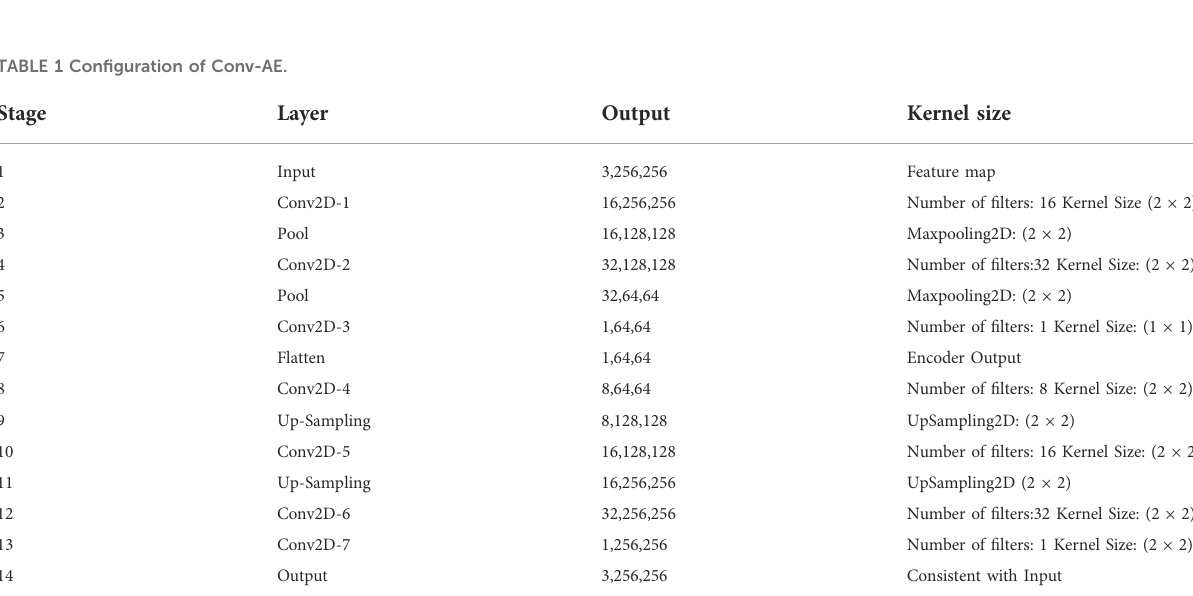
TABLE 1 Con fi guration of